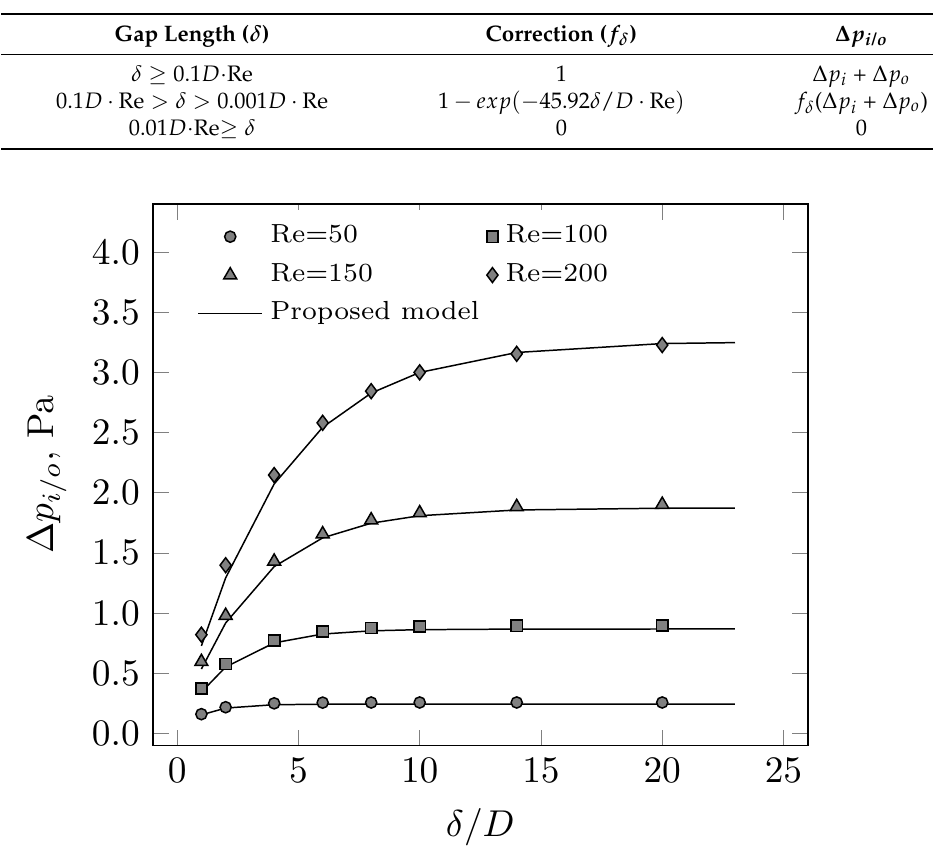
Table 2. Range of application of the proposed model.